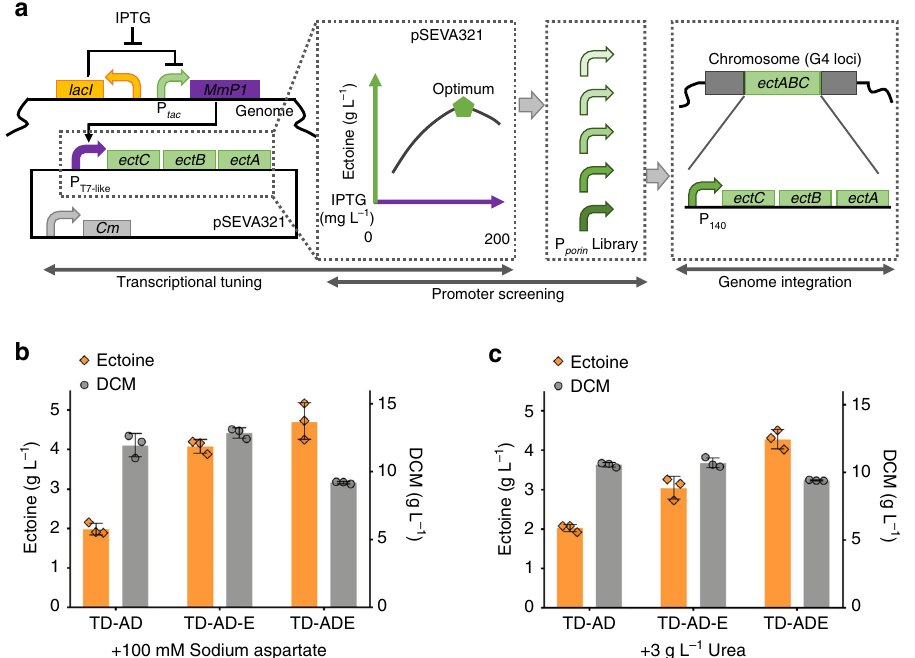
Fig. 5 Chromosomal expression of ectABC in H. bluephagenesis TD1.0 for ectoine production. a Transcription-tuning design based on stimulus responsive fl ux-tuning approach mediated by sfGFP fl uorescence intensity. Reprinted from Metabolic Engineering, 57, Jianwen Ye, Dingkai Hu, Jin Yin, Wuzhe Huang, Ruijuan Xiang, Lizhan Zhang, Xuan Wang, Jianing Han, Guo-Qiang Chen, Stimulus response-based fi ne-tuning of polyhydroxyalkanoate pathway in Halomonas , 85 – 95, Copyright (2020), with permission from Elsevier. b , c Shake fl ask results of ectoine production by recombinant H. bluephagenesis TD1.0 (TD-AD) and its derivates with ectABC expression on plasmid-based system in the presence of 20 mg L − 1 IPTG (TD-AD-E) and chromosome-based system under the control of porin promoter mutant P 140 (TD-ADE), respectively. b Cells cultured in a 60MME medium, while ( c ) were grown in the 60MMU medium for de novo biosynthesis of ectoine. Data are presented as mean values; error bars represent standard deviations (SD); n = 3 biologically independent samples. Source data underlying ( b , c ) are provided as a Source Data fi